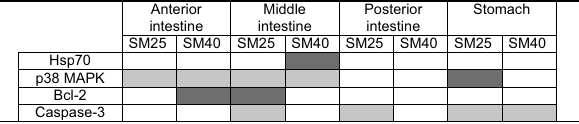
Table 2 Changes in the levels of the examined proteins between SM25 and SM40 compared to control FM treat- ment (dark grey indicates increase, light grey indicates decrease and white indicates no change compared to 4F-0S) Anterior Middle intestine